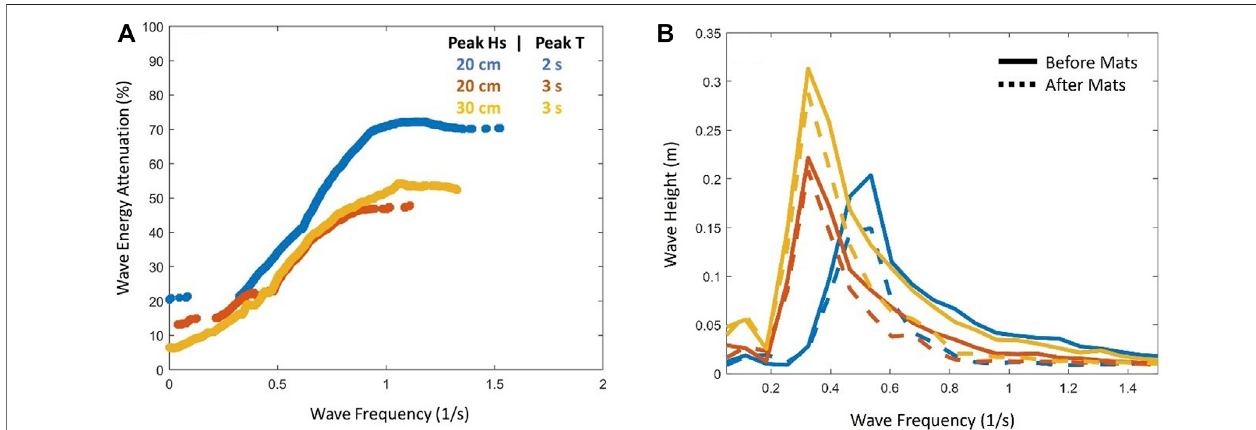
FIGURE9|(A) Wavefrequency(x-axis)versuswaveattenuation(y-axis)forthethreerandomcases(colorsandlegend)centeredonvaryingpeakwaveheightsand peak periods around a JONSWAP spectra with γ (cid:1) 3 . 3. (B) The resulting spectra measured by the wave gages located along the centerline of the mat network (in the directionofwavepropagation)areshowntopeakattheprescribedfrequencies(x-axis)andwaveheights(y-axis),withtheincidentwaveheight(solidline)higherthanthe resulting wave height (dashed line) in all cases. The distinction between solid and dashed lines is greater at higher frequencies (shorter waves), which aligns with results using regular wave conditions (see Figure 7 ).